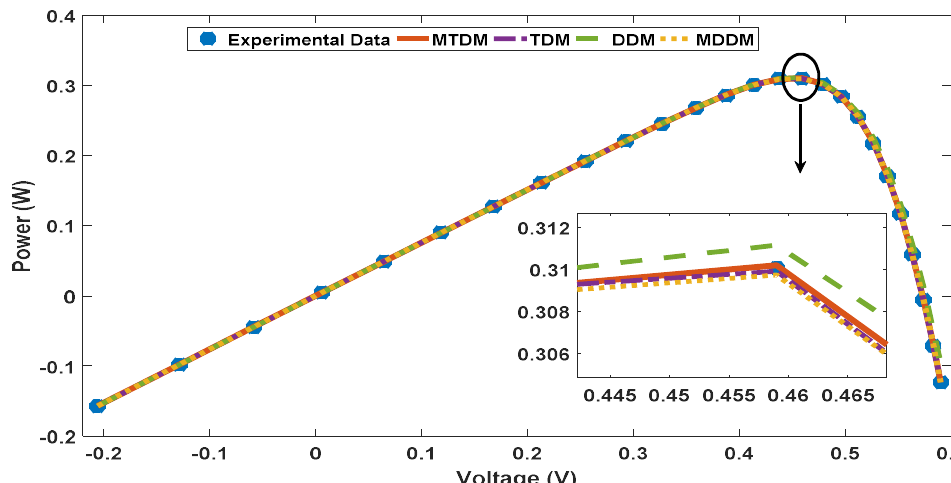
Figure 15. Power–voltage characteristic curve comparison between real data and all estimated models by WHO.